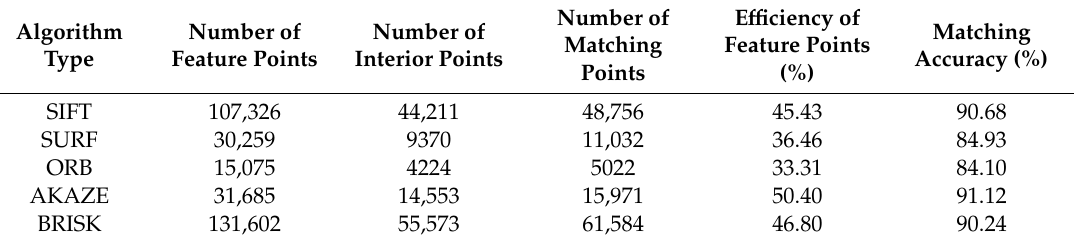
Table 1. Average time cost and average calculation cost of five types of operators. Table 2. Average number of e ff ective feature points and accuracy of five types of operators.